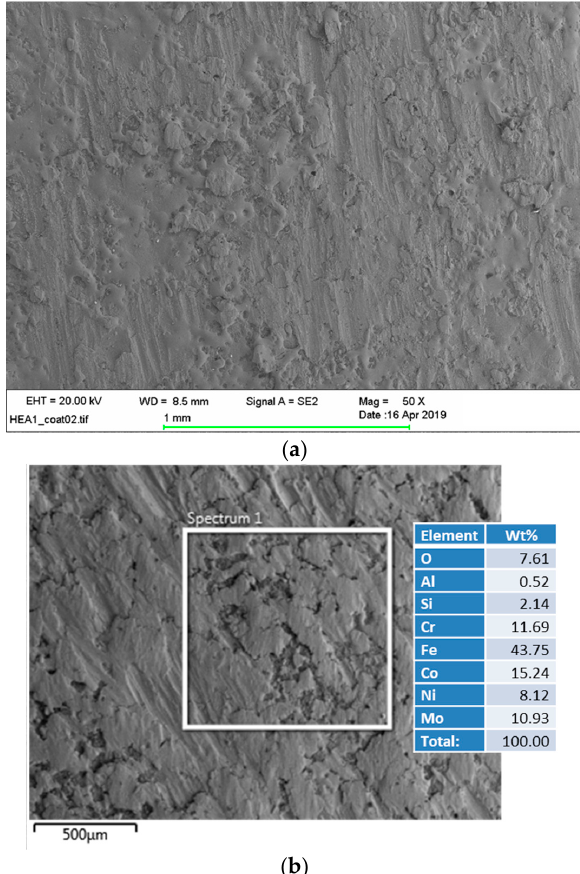
Figure 5. ( a , b ) SEM images of the surface of the CoCrFeNiMo coating; ( b ) includes a table with results from EDS analysis of the area identified with a white box in the SEM image.